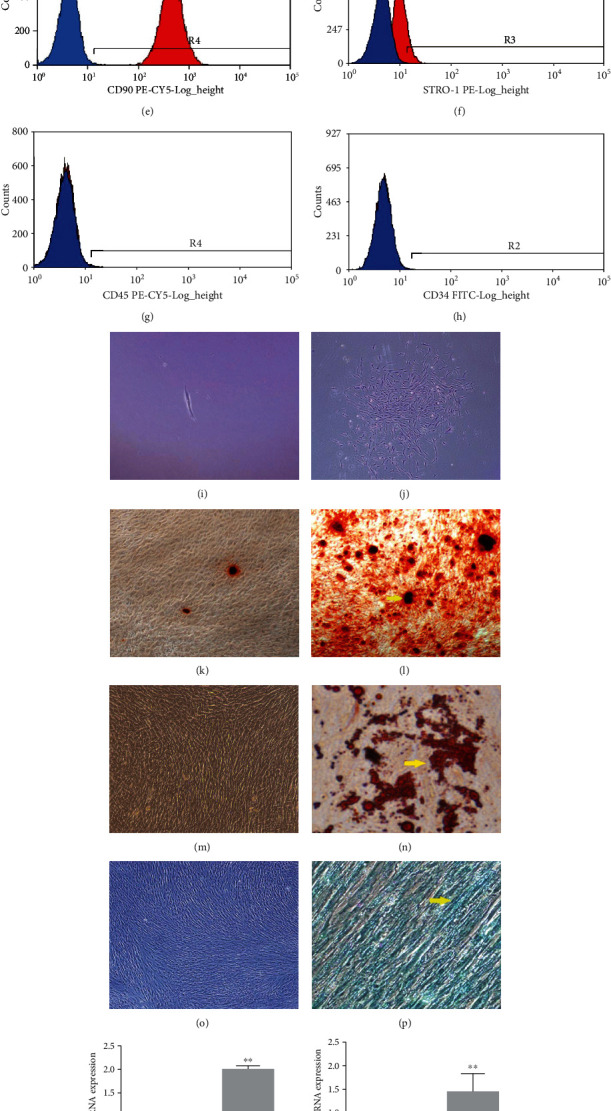
Identification and multiple differentiation potential of hDPSCs. (a) hDPSCs were separated from dental pulp. (b) hDPSCs were subcultured with normal media at third passage. (c–h) hDPSCs were positive for Stro-1 (18.39%), CD44 (99.99%), CD29 (97.96%), and CD90 (99.99%) and negative for CD45 (0.46%) and CD34 (0.35%). (i, j) A single cell was obtained, and single cell-derived colonies were obtained after culturing for 14 days. (k, 1) Noninduced group and induced group of odontogenic differentiation. Mineral nodes formed in the induced group were as indicated by the yellow arrow. (m, n) Noninduced group and induced group of adipogenic differentiation. Lipid droplets formed in the induced group were indicated by the yellow arrow. (o, p) Noninduced group and induced group of chondrogenic differentiation. Expressed glycosaminoglycans formed in the induced group were indicated by the yellow arrow. (q–s) In the induced group, upregulated expressions of odontogenic differentiation-related genes DSPP, DMPI, and OCN by qRT-PCR were shown, compared with the noninduced group. All samples were performed in triplicate. The data are represented as means ± SD. ∗P < 0.05, ∗∗P < 0.01.